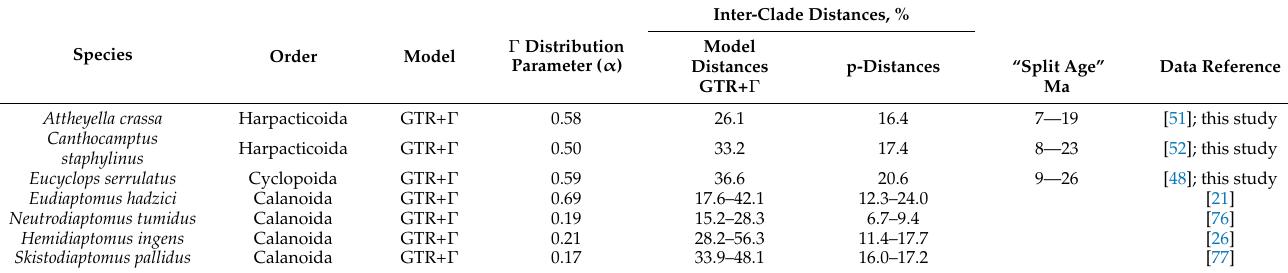
Table 7. Model-corrected COI genetic distances and observed p-distances between cryptic lineages of different freshwater copepod taxa. The rate variation parameter α was estimated for each dataset separately. The “split age” is a transformation of the model distance under a range of COI divergence rates between 1.4%–4% Ma − 1 , applied in some other crustacean studies